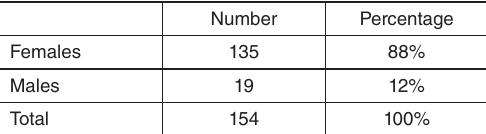
Table 1: Sample gender